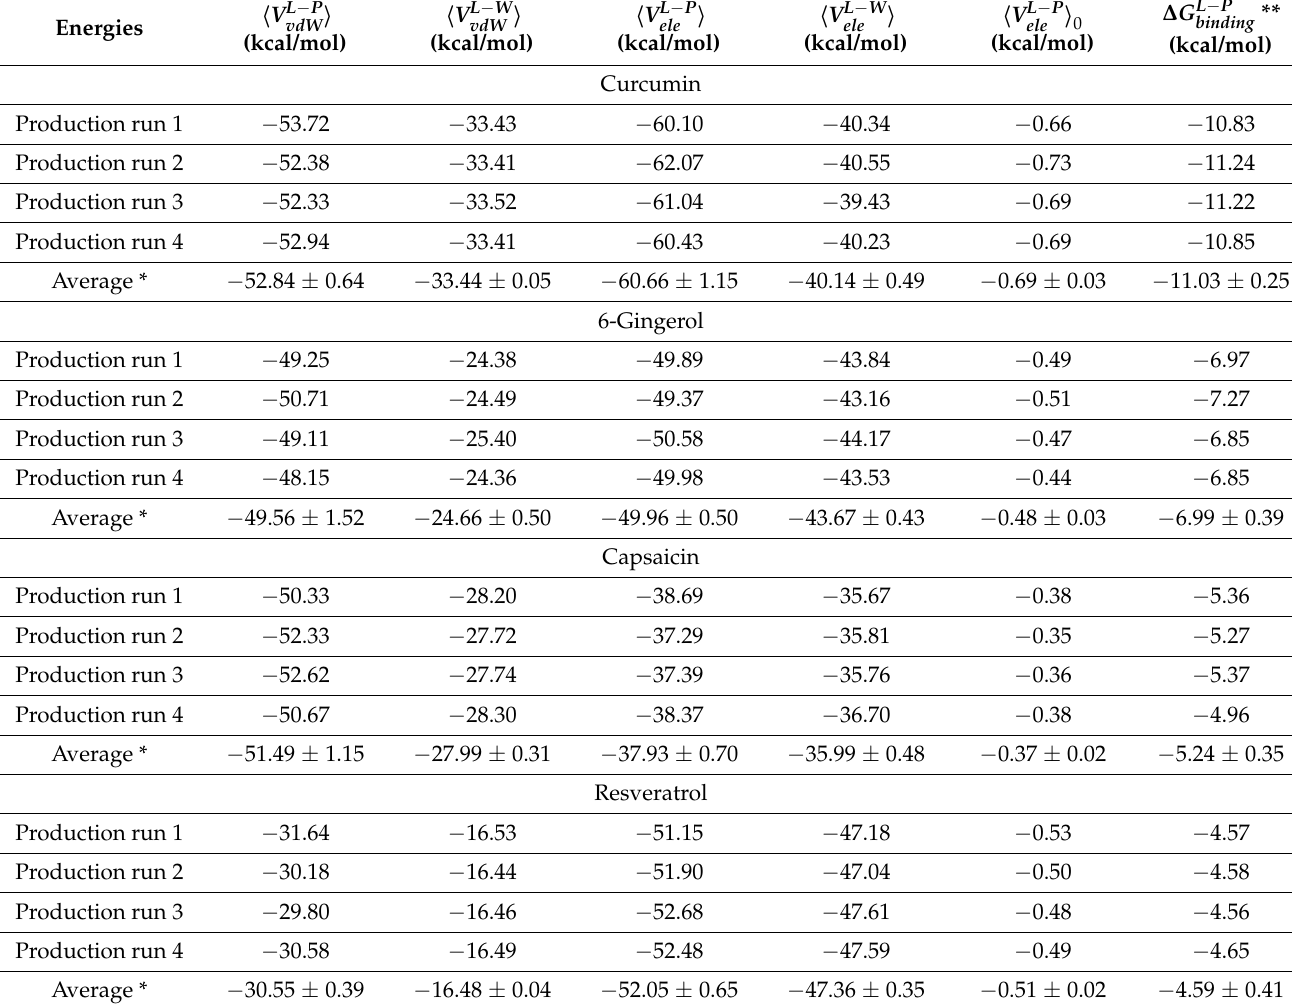
Table 5. The average electrostatic (ele) and van der Waals (vdW) nonbonded interactions of curcumin, 6-gingerol, capsaicin, and resveratrol in water (the free state W) as well as in complex with PDE4D (the bound state P) along with the corresponding binding free